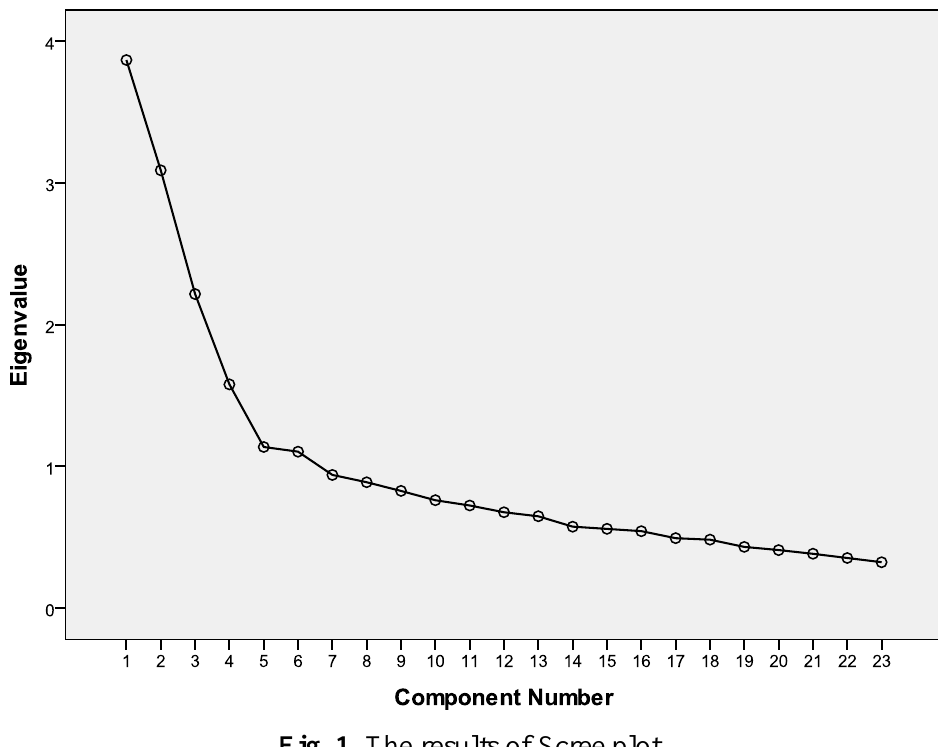
Fig. 1. The results of Scree